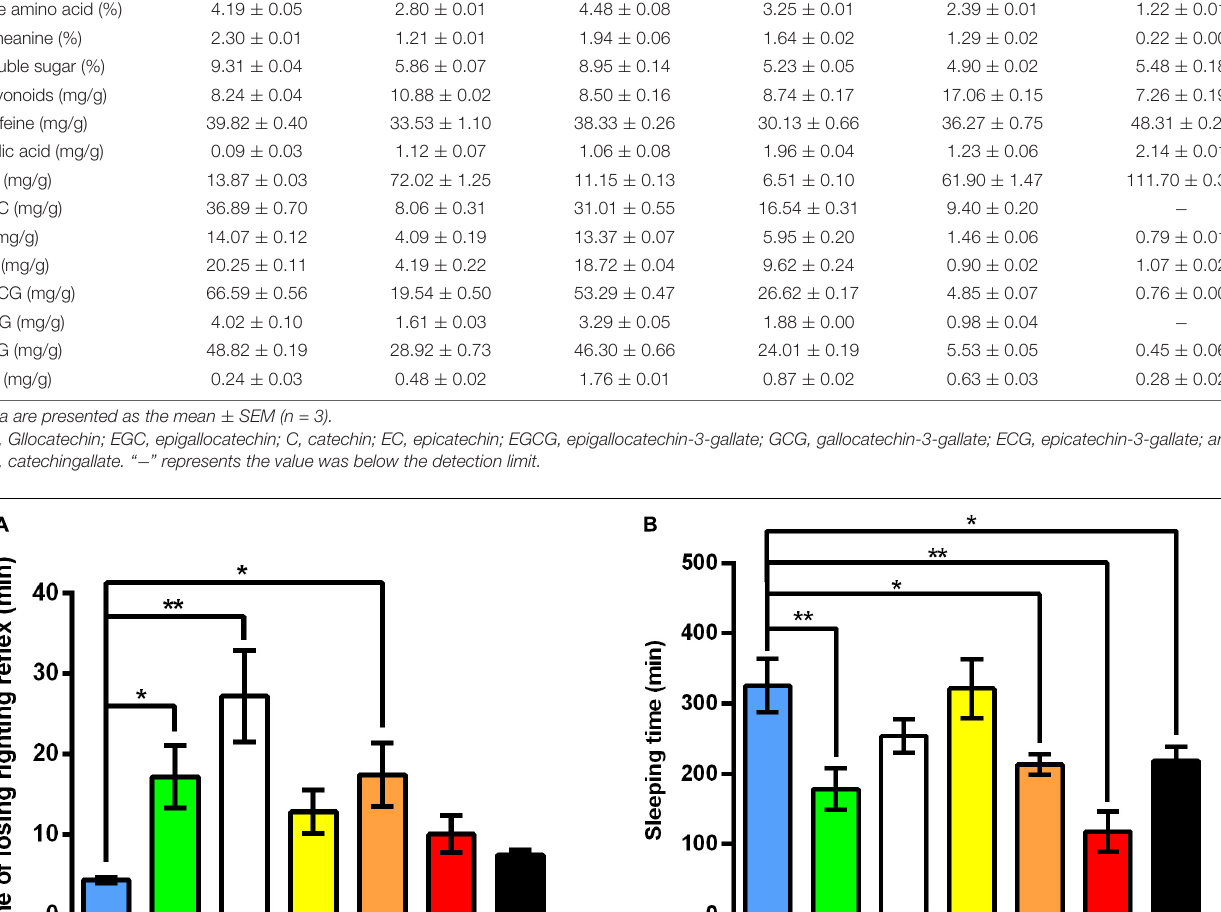
Frontiers in Nutrition |